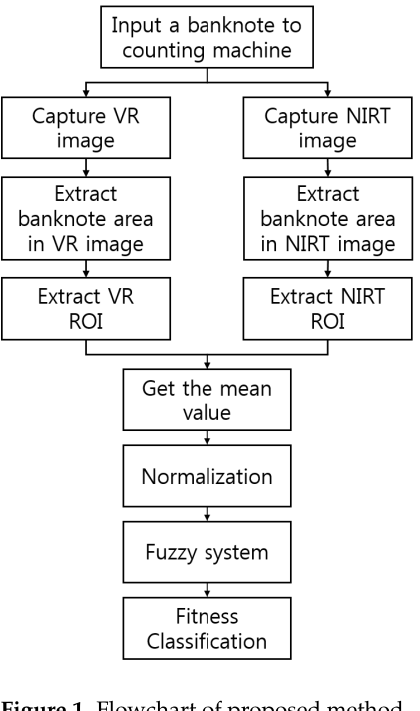
Figure 1. Flowchart of proposed method.